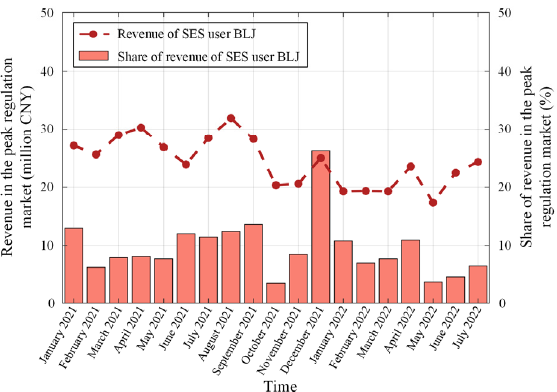
Figure 13. Revenue and its share of SES users in the peak-regulation ancillary service market in Gansu, China.